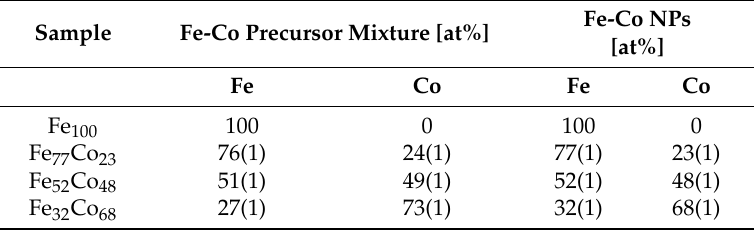
Table 2. Fe-Co alloy NPs. Comparison between the composition of the precursor powder mixture and of the synthesized NPs. The samples names reflect the NPs composition as determined by SEM-EDX.